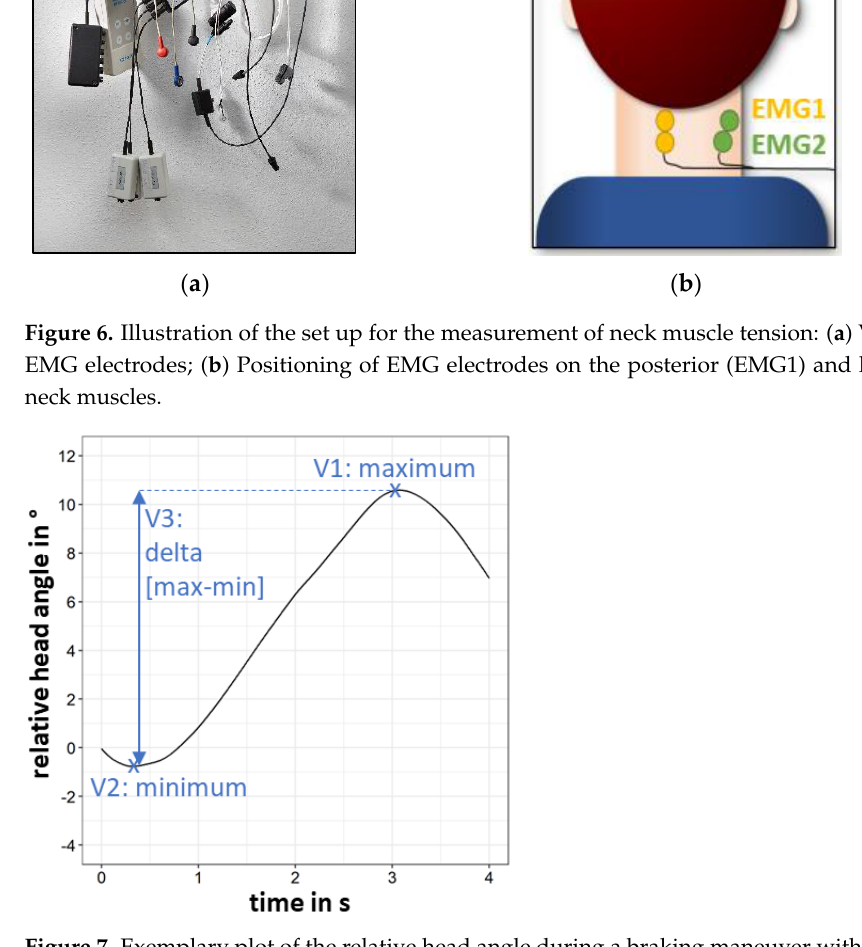
Figure 6. Illustration of the set up for the measurement of neck muscle tension: ( a ) Varioport with EMG electrodes; ( b ) Positioning of EMG electrodes on the posterior (EMG1) and lateral (EMG2) neck muscles.